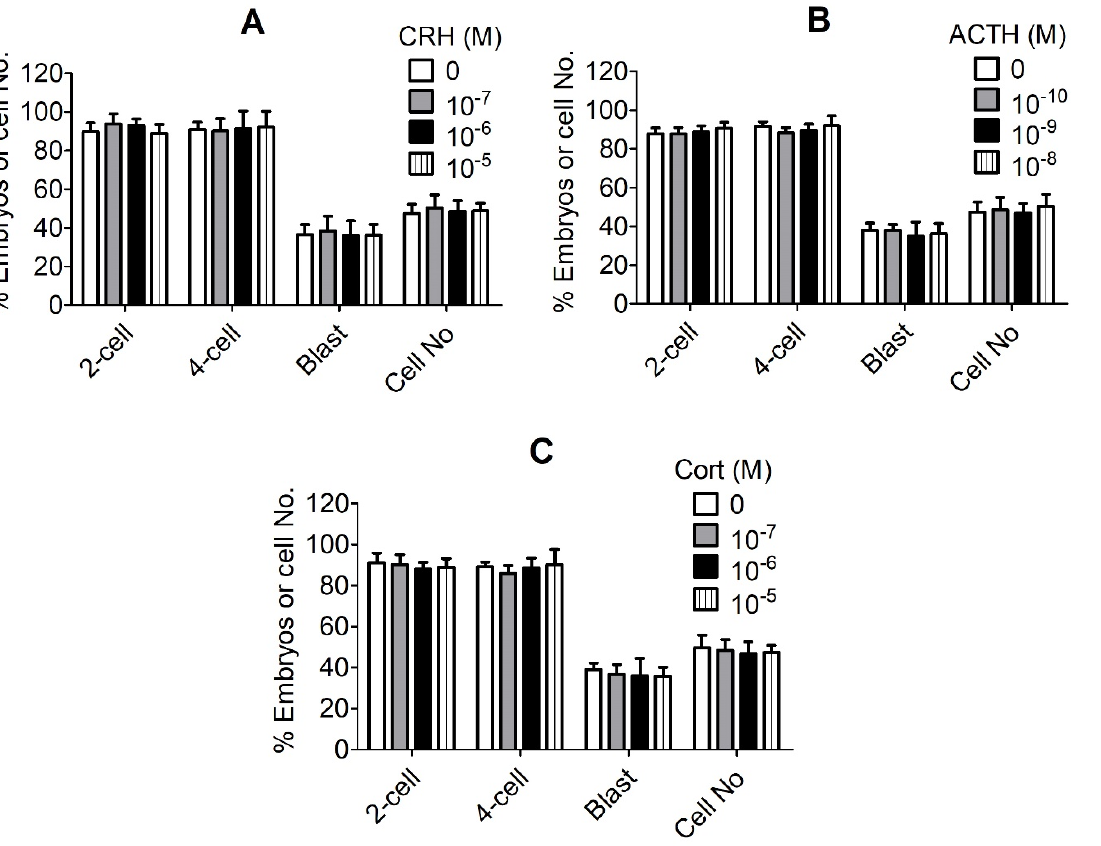
Figure 1. Effects of culture with different concentrations of corticotrophin-releasing hormone (CRH), adrenocorticotropic hormone (ACTH) or cortisol (Cort) on the embryo development of pig activated oocytes. Graphs ( A – C ) show embryo development after culture with CRH, ACTH and Cort, respectively. Matured (MII) oocytes showing first polar body (PB1) were chemically activated and cultured in the presence of different concentrations of CRH, ACTH or Cort before observation for embryo development. Three concentrations of each hormone, plus a blank control, were used. Each treatment was repeated four times with each replicate containing approximately 25 MII oocytes. While 2-cell and 4-cell embryos were observed at 48 h, blastocysts were observed on day 6 after the onset of embryo culture. Percentages of 2-cell, 4-cell and blastocyst (Blast) embryos were calculated from MII oocytes, 2-cell and 4-cell embryos, respectively. Cell numbers (Cell No) per blastocyst were counted from all the blastocysts collected from each treatment. No significant effect of any concentration of any hormone was observed on any stage of embryo development.